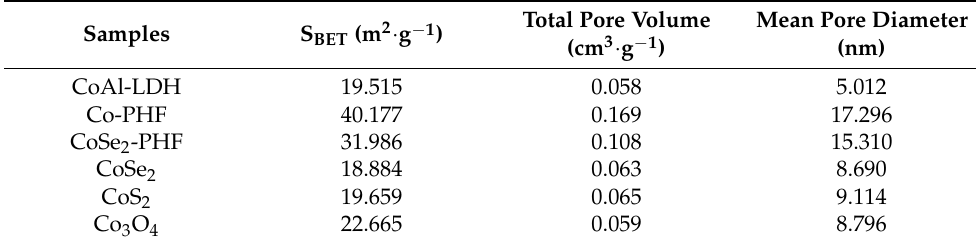
Table 1. Specific surface area, total pore volume and average pore diameter of different samples.